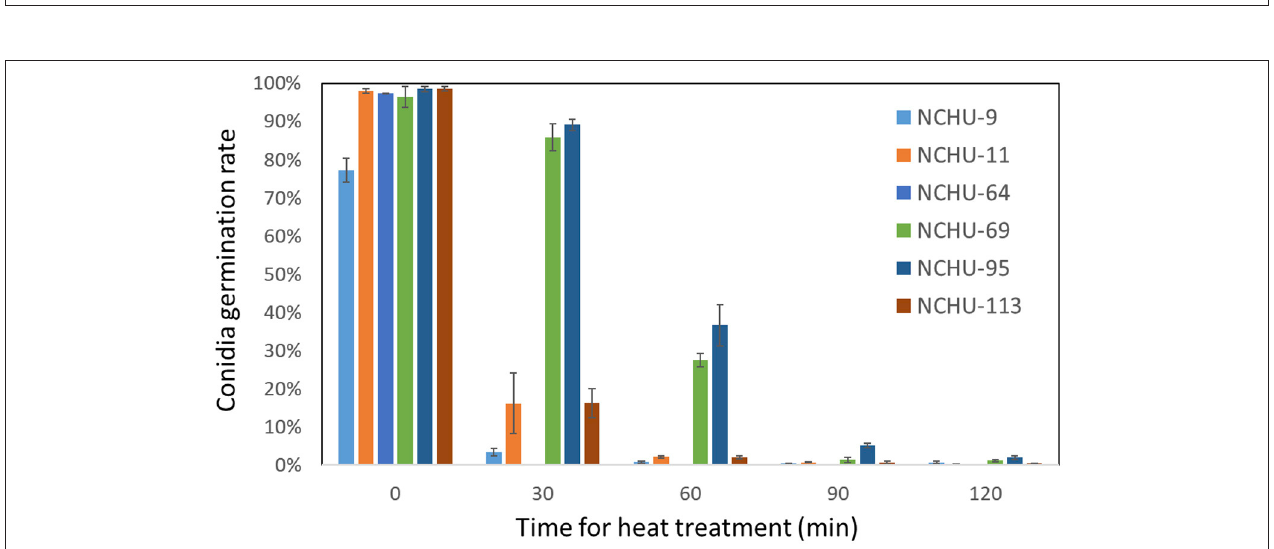
Frontiers in Sustainable Food Systems |